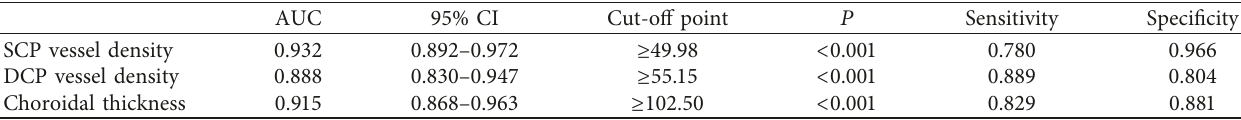
Table 4: The area under the curve and cutoff values of vessel density and choroidal thickness for differential diagnosis of diffuse chorioretinal atrophy (C2).